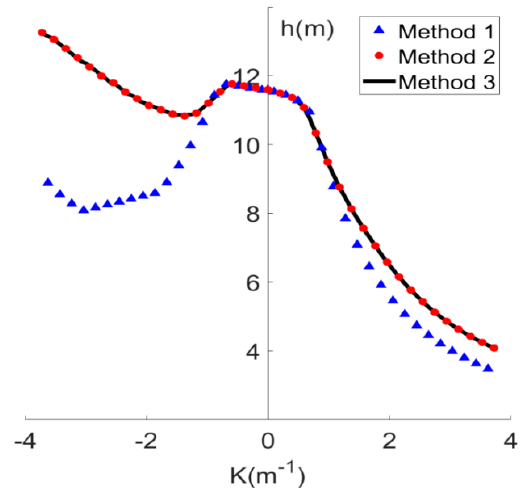
Figure 11. Height of neutral axis in CASE 1.